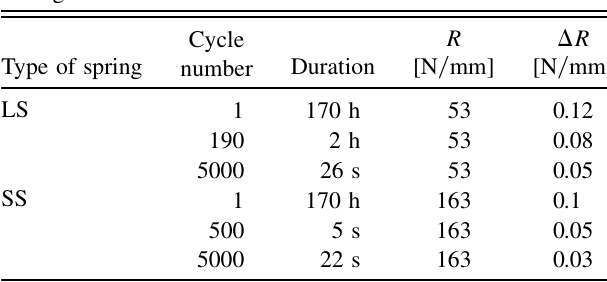
TABLE VI. Rigidity coefficient variation of long springs (LS) and short springs (SS) after compression tests. R and (cid:2) R are, respectively, the mechanical rigidity and its variation after